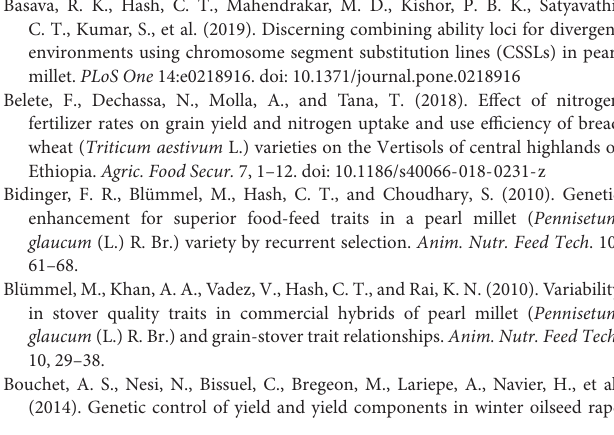
Supplementary Table 1 | Details of soil properties before establishment of experimental plot. Supplementary Table 2 | Phenotypic data of 380 pearl millet genotypes for five traits (SPAD, Leaf number, Leaf area, Grain yield, and Dry stover yield) at three N levels. Mean values of over three seasons (summer 2017, rainy 2017, and summer